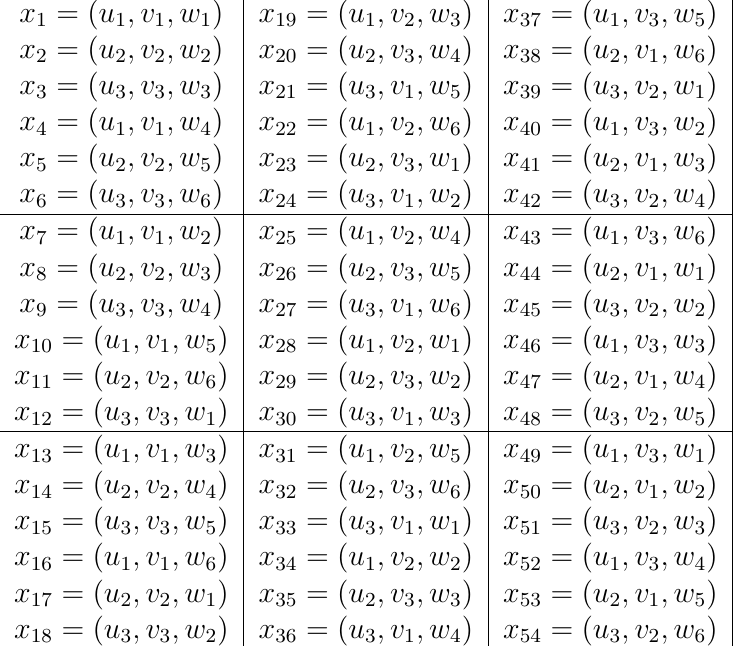
Table 1: The list of x